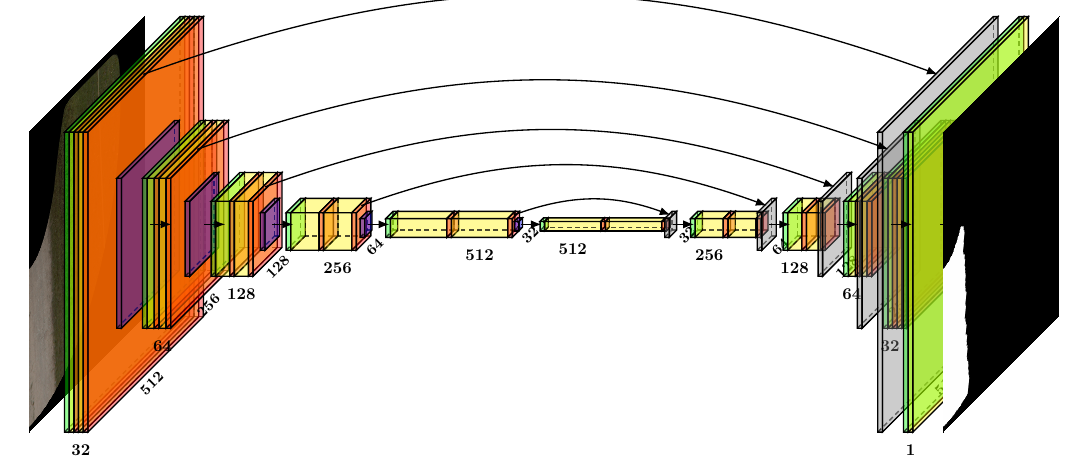
Figure 4. Illustration of Road Segmentation Network (RSN)